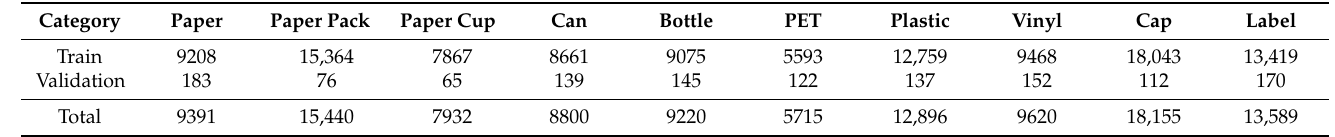
Table 1. Annotation data for each category and